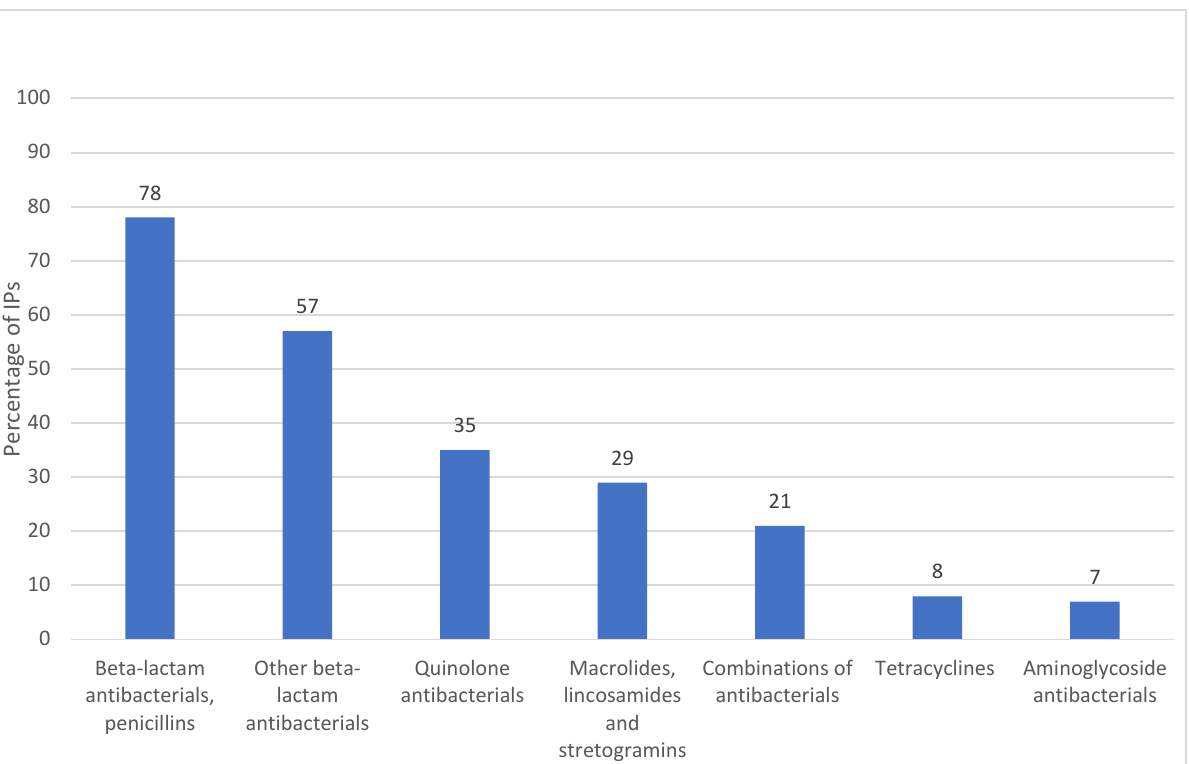
Figure 2. Percentages of IPs stocking antibiotics by the WHO anatomical therapeutic chemical (ATC) classification system [41] (n = 196).